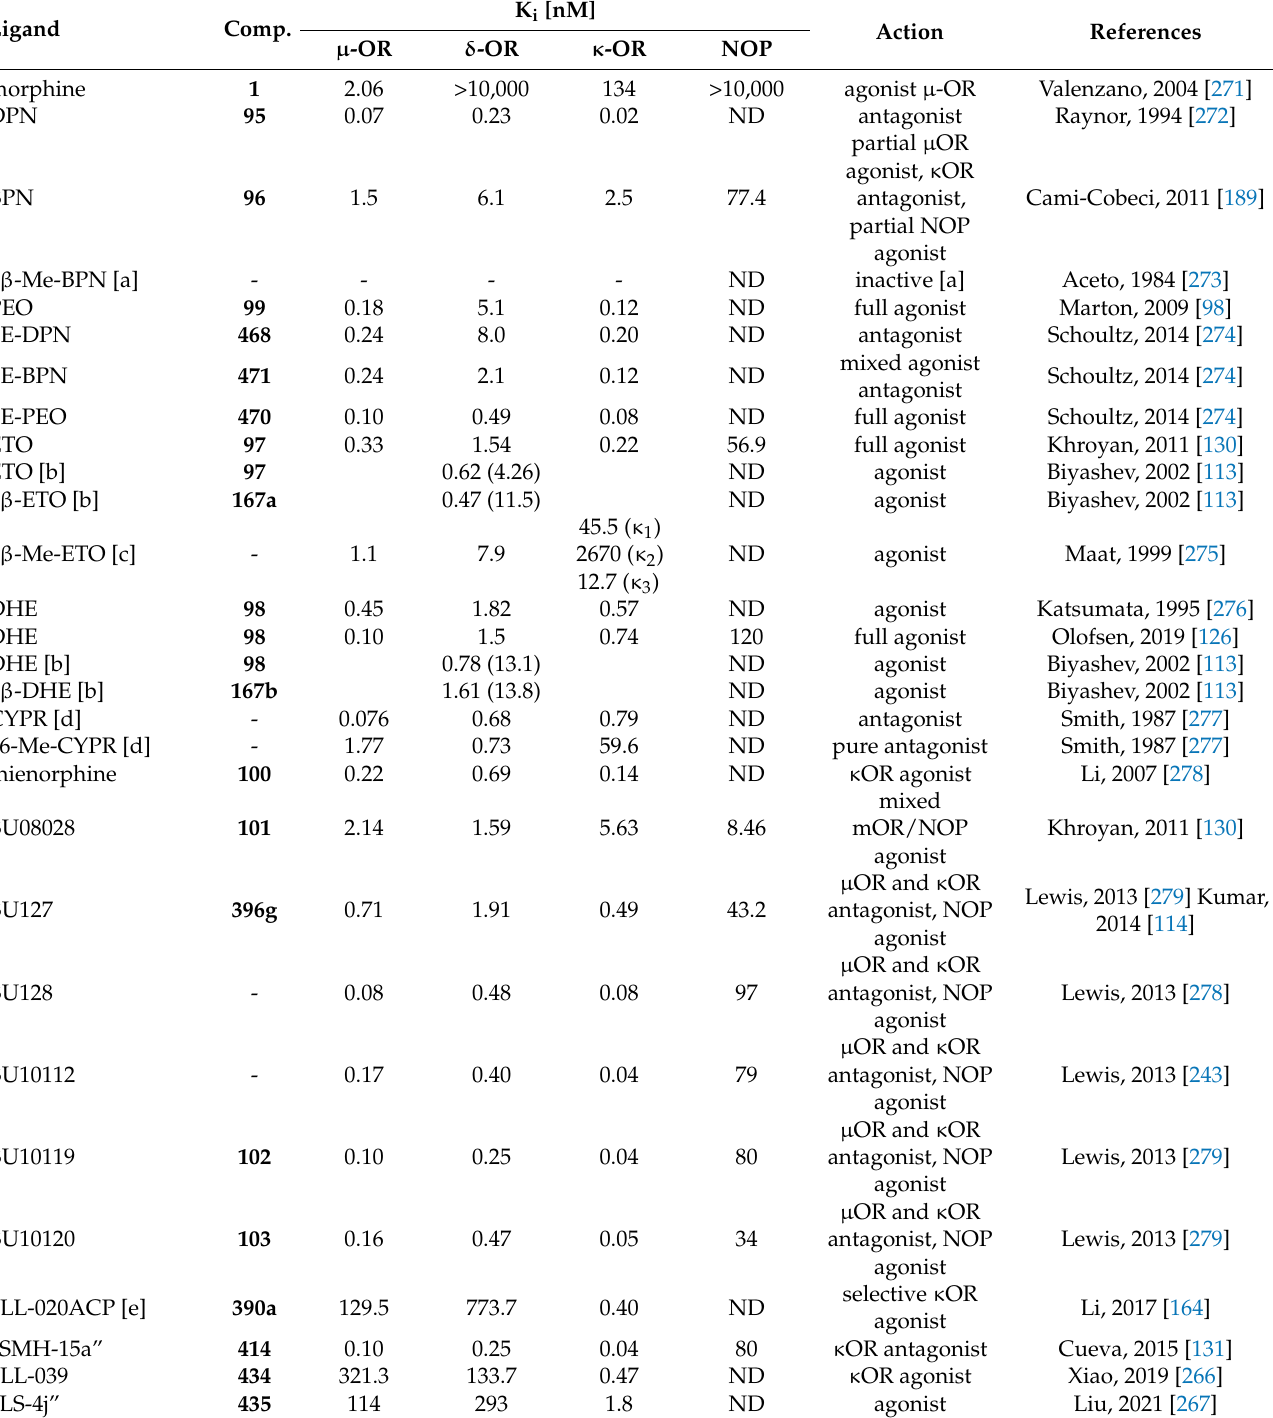
Table 3. Binding profile of selected 6,14-ethenomorphinan ligands at the human opioid receptors [22]. Ligand